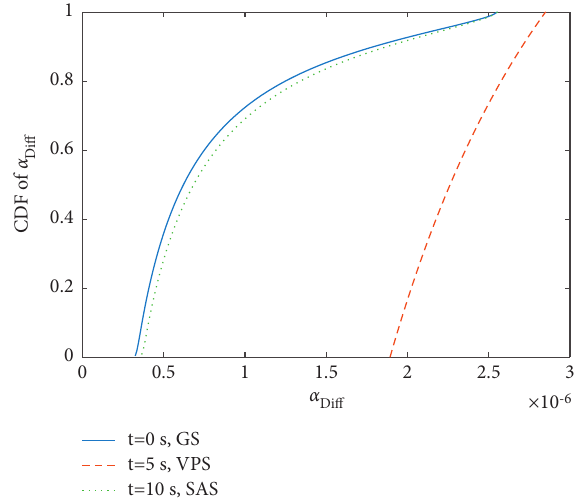
Figure 9: The CDFs of α